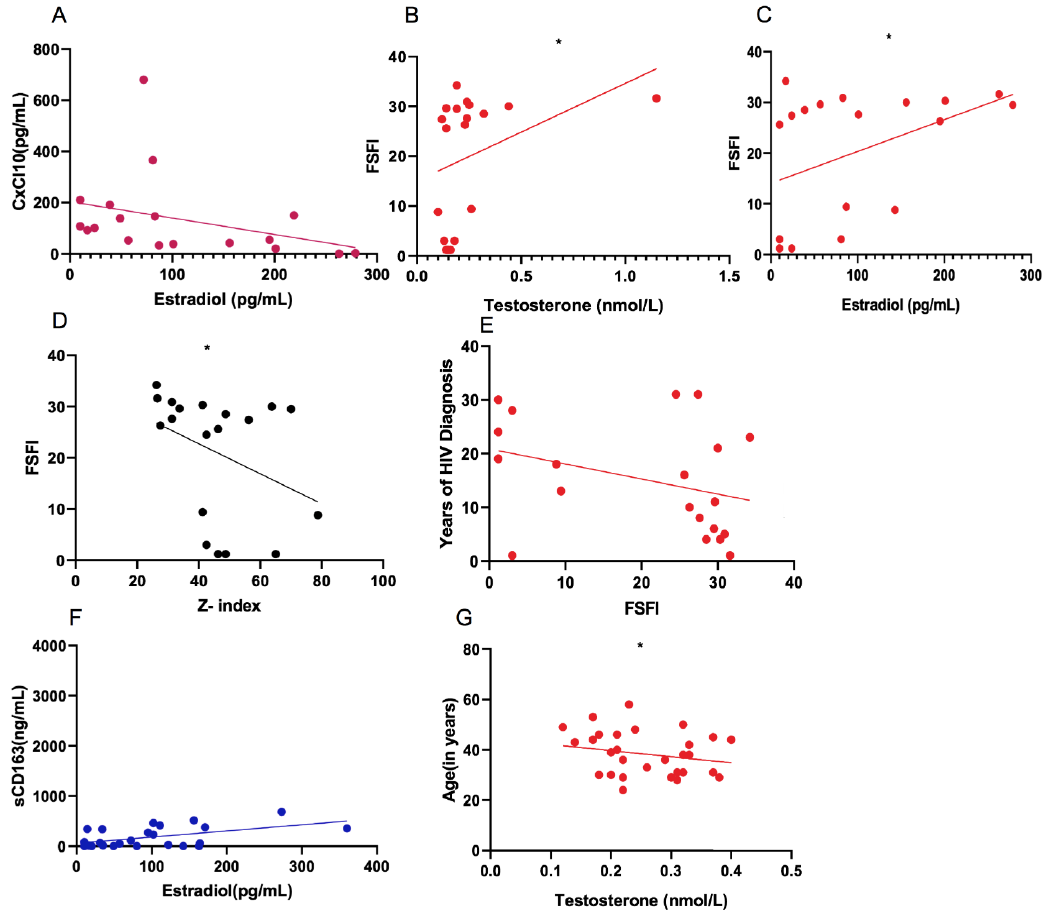
Figure 7. Correlations. ( A ) Positive correlation between CxCl10 and estradiol levels (r = 0.5, p = 0.01) in WLWH. ( B ) Positive correlation between FSFI and testosterone levels (r = 0.56, p = 0.02) in WLWH. ( C ) Positive correlation between FSFI and estradiol levels (r = 0.51, p = 0.02) in WLWH. ( D ) Negative correlation between FSFI and anxiety (Z-index) (r = − 0.49, p = 0.03) in WLWH. ( E ) Negative correlation between years of HIV diagnosis and FSFI in WLWH (r = − 0.43, p = 0.05). ( F ) Positive correlation between plasmatic sCD163 and estradiol levels (r = 0.3, p = 0.05) in HW. ( G ) Negative correlation between the age of the individuals and testosterone levels (r = − 0.5, p = 0.01) in HW. All correlations were performed using the Spearman test. * p < 0.05.